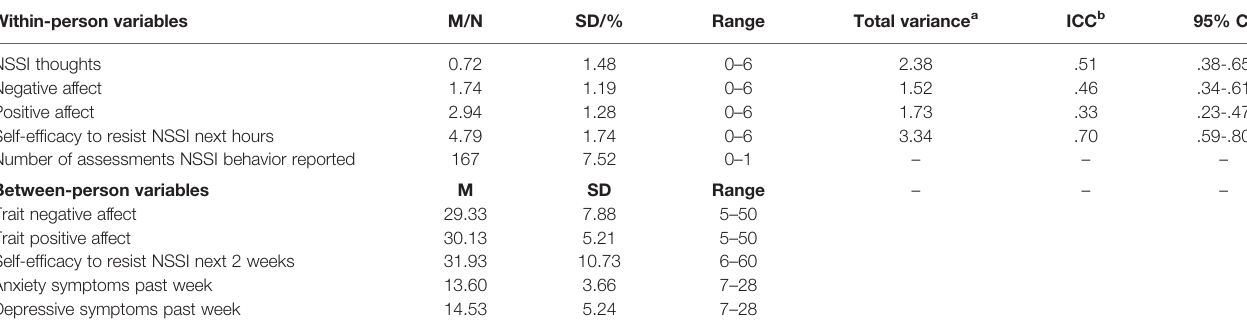
TABLE 2 | Descriptive and variability statistics of negative affect, positive affect, self-ef fi cacy to resist NSSI, and NSSI thoughts and behaviors during 12-day experience sampling protocol. Within-person variables M/N SD/% Range NSSI